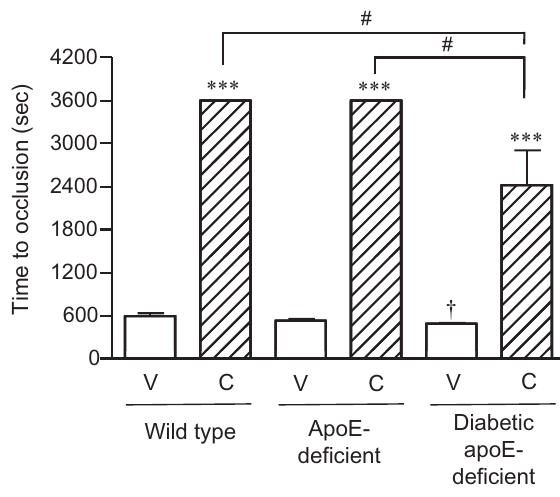
Fig. 2 Effect of clopidogrel on time to fi rst occlusion. Clopidogrel (C) at 10 mg/kg/d (orally) or vehicle (V) was administered once daily for 5 days to wild-type (WT), apoE-de fi cient, and diabetic apoE-de fi cient mice ( n ¼ 10 per group). Carotid artery occlusion was initiated by application of FeCl 3 2 hours after the last dose of clopidogrel, arterial blood fl ow was monitored, and the time in seconds to fi rst occlusion was determined. The results are presented as the mean þ SE ( n ¼ 10). (cid:5)(cid:5)(cid:5) p < 0.001 versus each vehicle group, † p < 0.05 versus the vehicle group of WT mice, # p < 0.05 (Student ’ s t